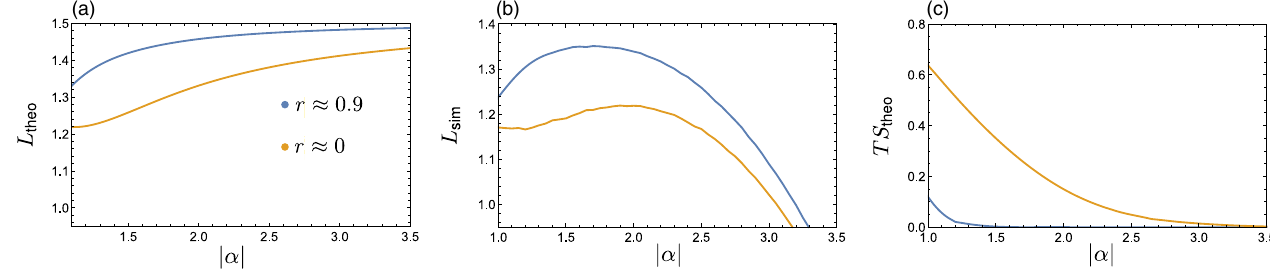
FIG. 12. Theoretical comparison of a LGI experiment using a ground-state cooled or a squeezed oscillator state. Results are presented for a squeezing parameter r ≈ 0 . 9 . (a) Analytic calculation of the achievable L values. (b) Simulated L values including the same motional dephasing and linewidths as in the simulations in the main part of the paper Fig. 4(b). (c) Analytic calculation of the amount of TS present during the